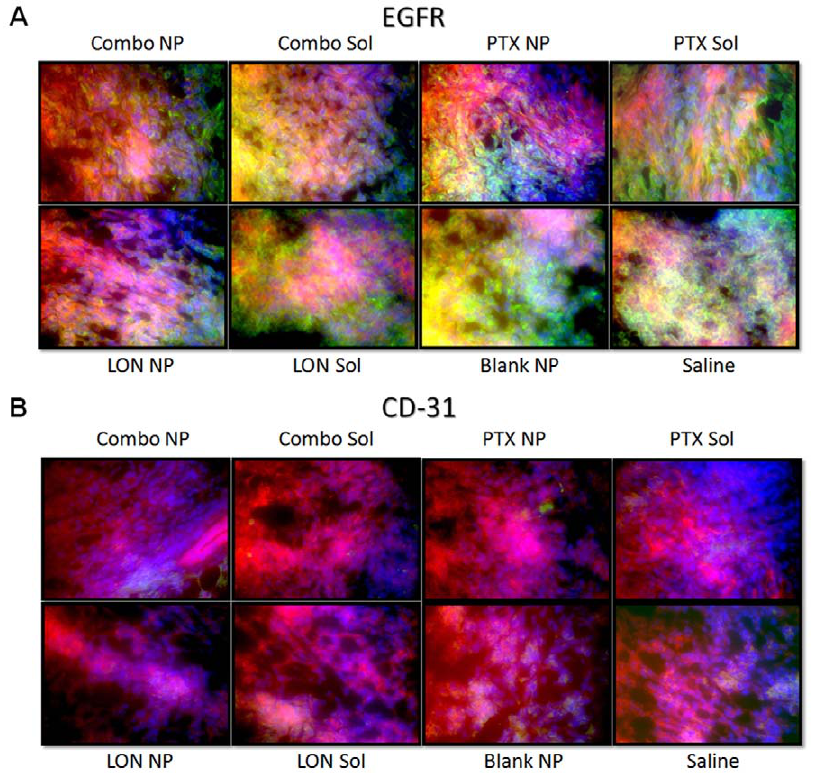
Figure 7. Immunohistochemistry of EGFR and CD-31. Tissue sections were probed with primary antibodies against the protein of interest, then labeled with Alexa Fluor H 488 conjugated secondary antibodies (green). F-actin was stained with Alexa Fluor H 568 phalloidin (red) and nuclei were stained with Hoechst 33342 (blue).